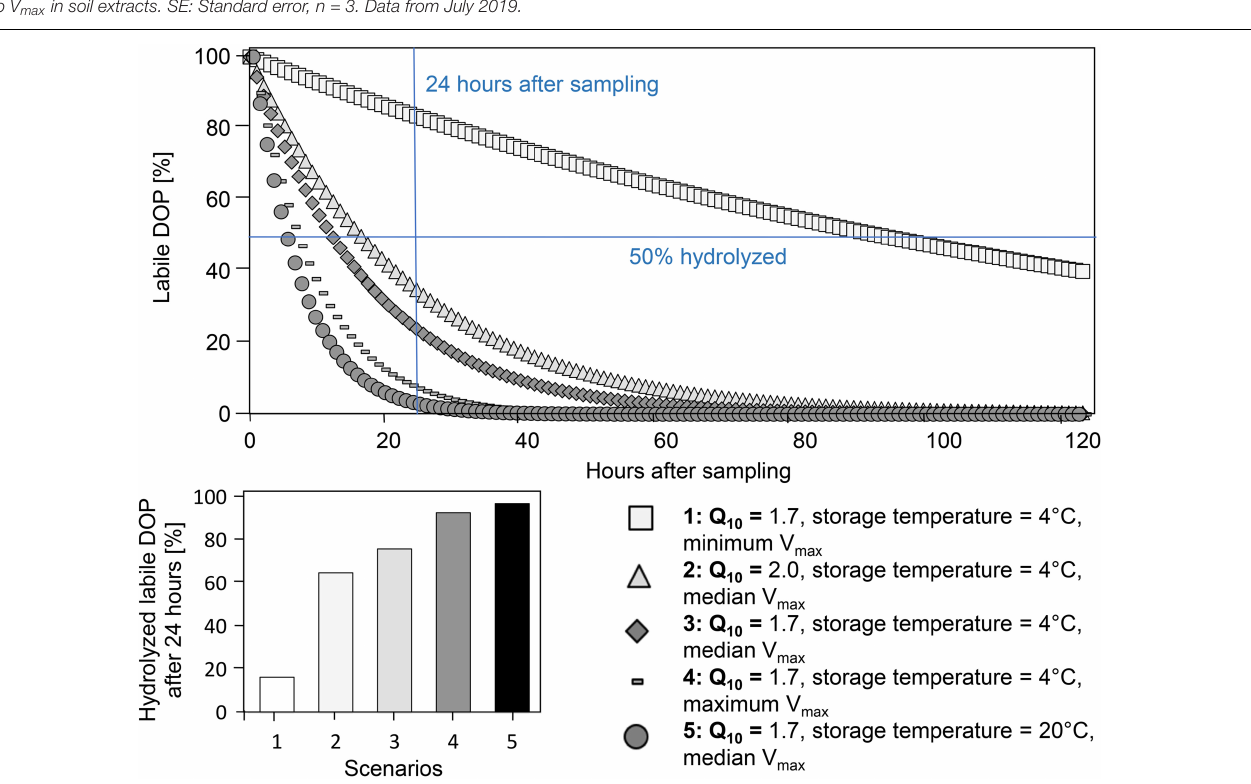
FIGURE 5 | Hydrolysis of labile dissolved organic phosphorus (DOP) in leached soil solutions estimated within a range of V max values: lowest, median, and highest V max derived from this study, including two storage temperatures, and two Q 10 values. V max and K M from